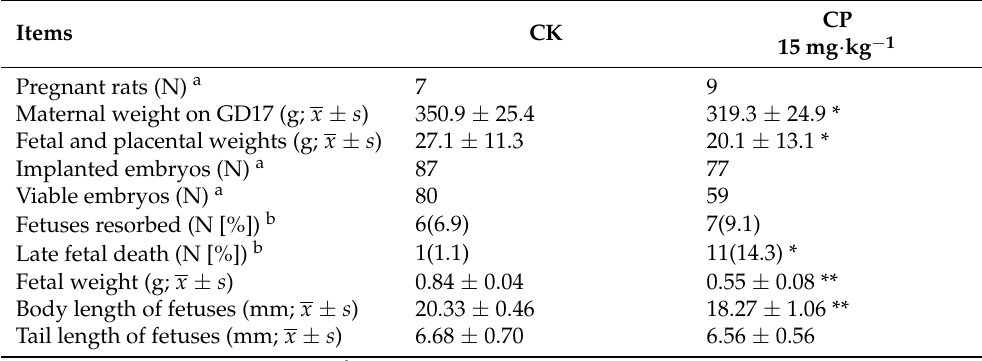
Table 1. Effects of CP on fetuses on GD17.